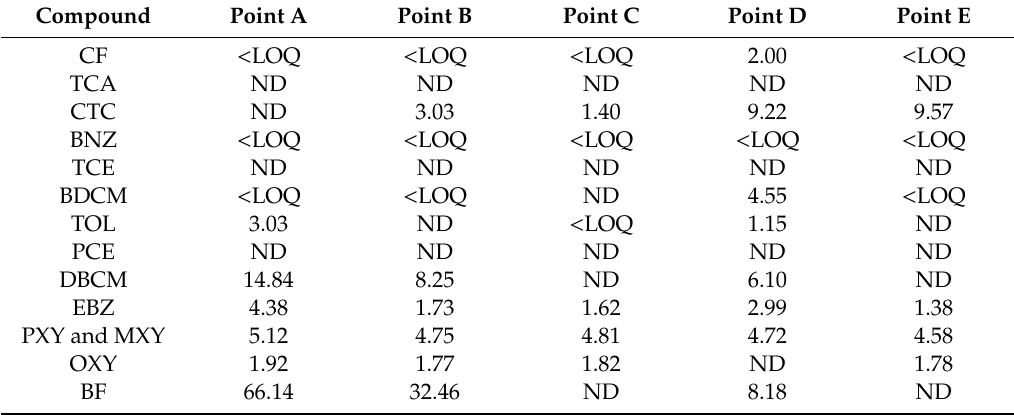
Table 5. VOC concentrations ( µ g / L) in the wastewater reservoir of a petrochemical plant complex in South